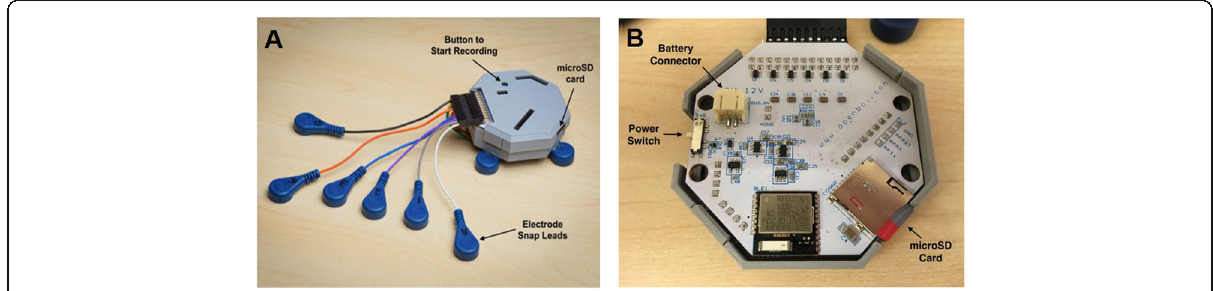
Fig. 2 Electrogastrogram System Design. A Cutaneous electrode attached to ( B ) 24-bit OpenBCI Cyton